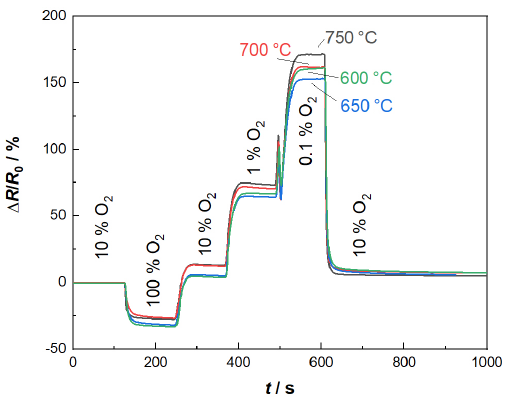
Figure 4. Initial test of the multi-gas sensor consisting of the NO x sensor film and the BFAT oxygen sensor film, heated by a tube fur- nace at 650 ◦ C (“passively heated” sensor); NO variation (100, 600, 1200ppm) at three different compositions: composition 1: 15% O 2 and 3% CO 2 ; composition 2: 7.5% O 2 and 6.5% CO 2 ; composi- tion 3: 2% O 2 and 10% CO 2 , all balanced in N 2